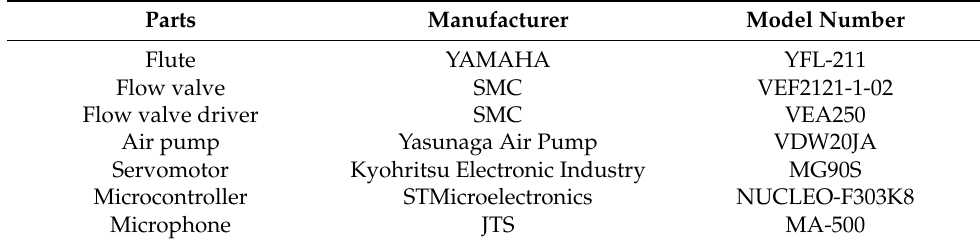
Table 1. Parts used in the flute-playing